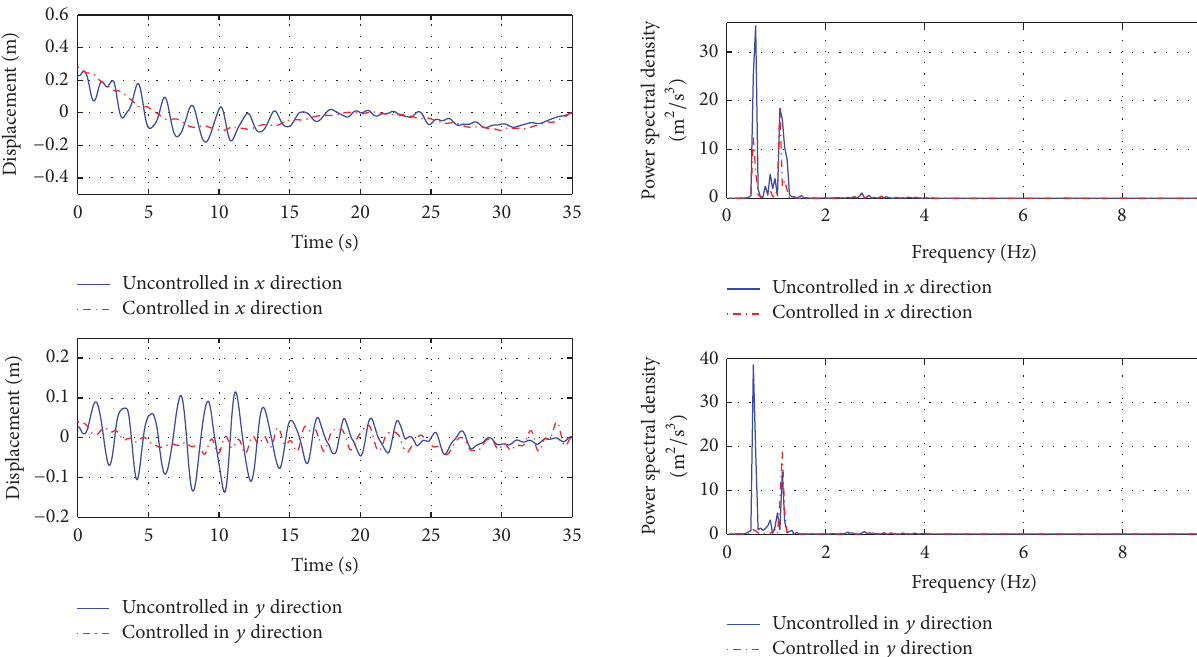
Figure 17: Acceleration power spectral density of the tower top. axis of the multiple cardan gyroscope are described, and the dynamic equation of the gyroscope is established.